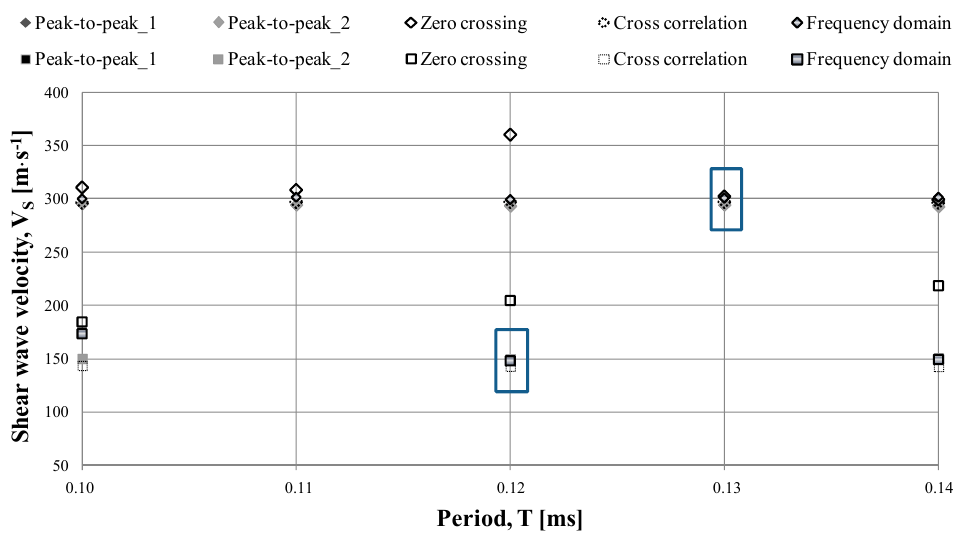
Figure 10. Variation of V S with period for p ′ = 90 kPa. Diamond symbols: pure RCA specimens; rectangle symbols: compositions of RCA with rubber chips.